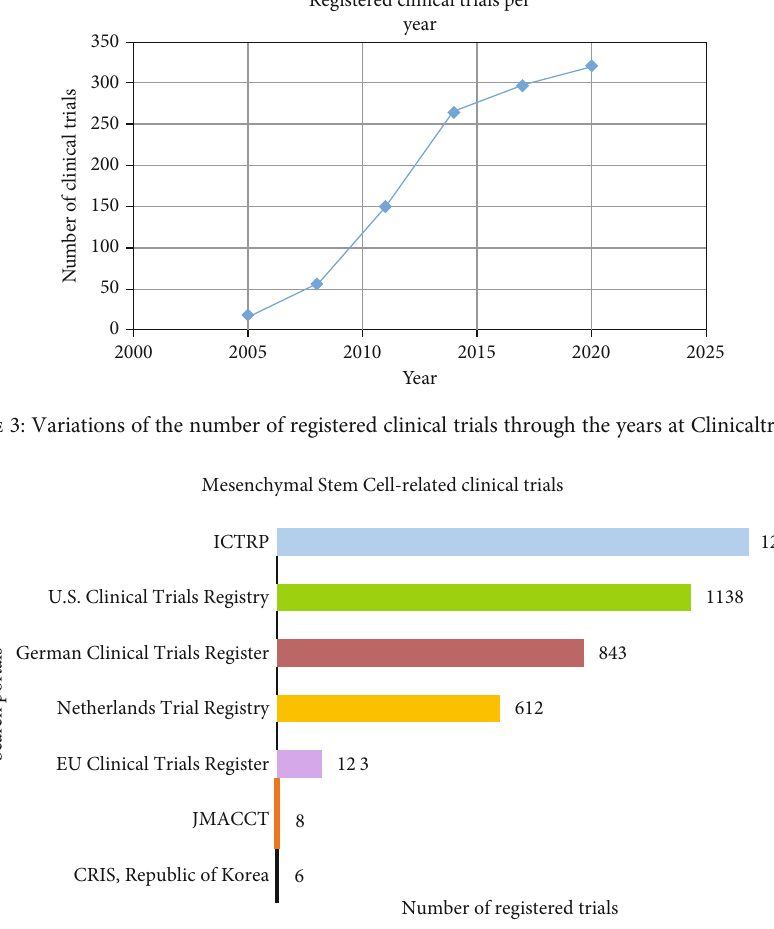
Figure 4: Mesenchymal stem cell-related clinical trial registry among di ff erent search portals. Search portals: ICTRP: International Clinical Trials Registry Platform (https://apps.who.int/trialsearch/AdvSearch.aspx); Chinese Clinical Trial Registry (http://www.chictr.org.cn/index .aspx); U.S. Clinical Trials Registry (http://www.clinicaltrials.gov/); German Clinical Trials Register